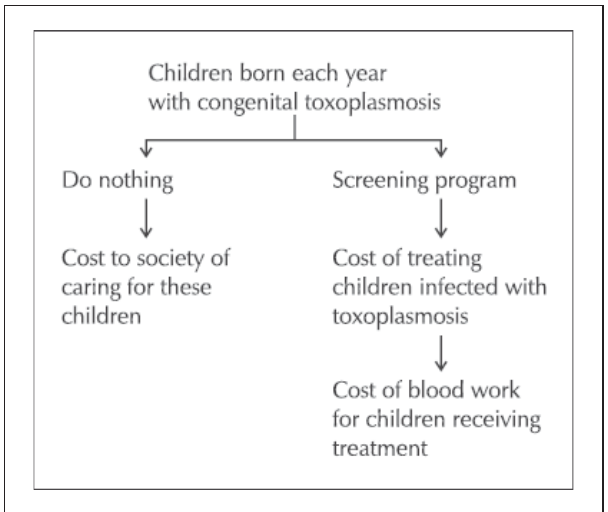
Figure 1) Flow chart of estimated costs of caring and treating children born with